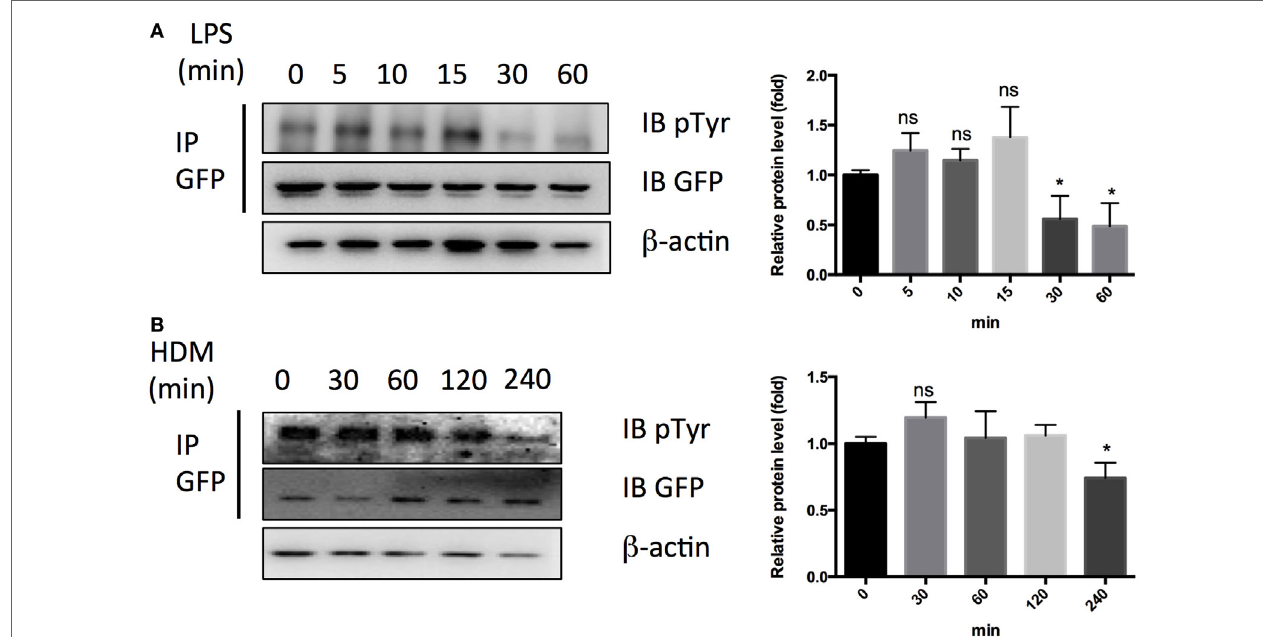
FigUre 7 | Dephosphorylation of polymerase I and transcript release factor in response to LPS and HDM. (a) Whole cell lysates from HBE cell treated with LPS (1 ng/µl) were immunoprecipitated by GFP antibody followed by SDS-PAGE and blotted with indicated antibodies. Quantitative analysis of pTyr/GFP ratio is shown in right panel. (B) Whole cell lysates from HBE cell treated with LPS (1 ng/µl) were immunoprecipitated by GFP antibody followed by SDS-PAGE and blotted with indicated antibodies. Quantitative analysis of pTyr/GFP ratio is shown in right panel. * p < 0.05, ** p < 0.01, *** p < 0.001, as determined by Student’s t